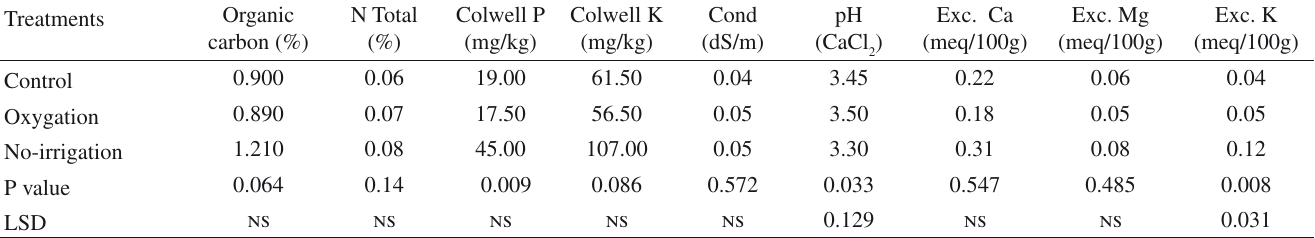
Table 3 - Macro nutrients, organic carbon, soil pH, conductivity (Cond) and exchangeable calcium (Exc. Ca), exchangeable magnesium (Exc. Mg), exchangeable potassium (Exc. K) in the soil sampled after the ratoon crop in oxygation, control and no-irrigation